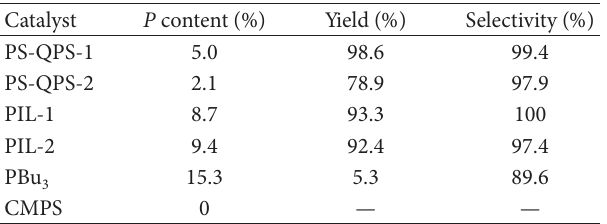
T 1: Cycloaddition reactions of CO different